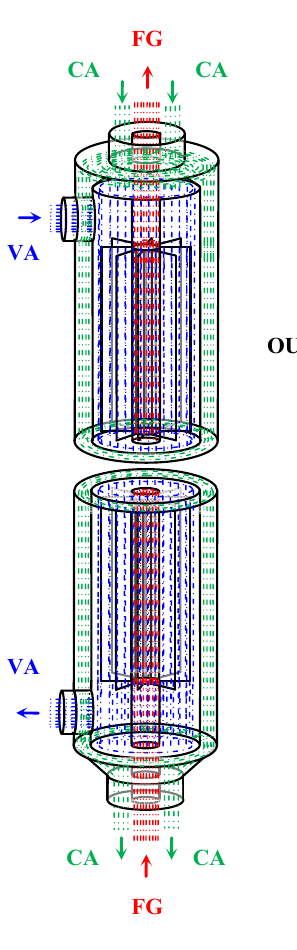
Figure 3 . Diagram of the